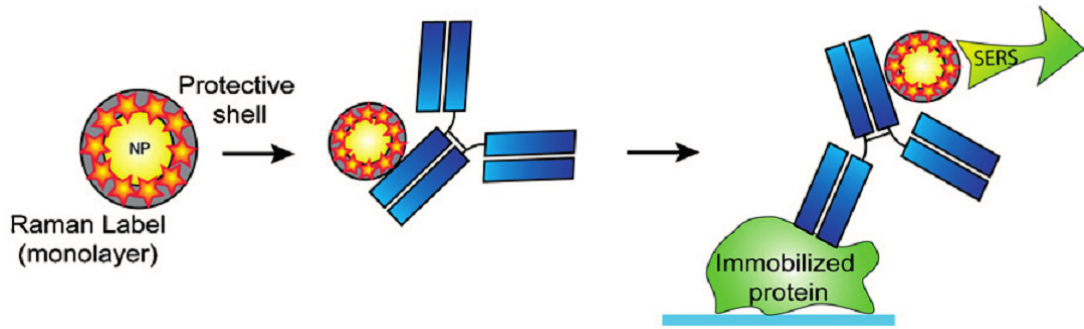
Figure 7. Graphical representation of immune-detection with Raman label